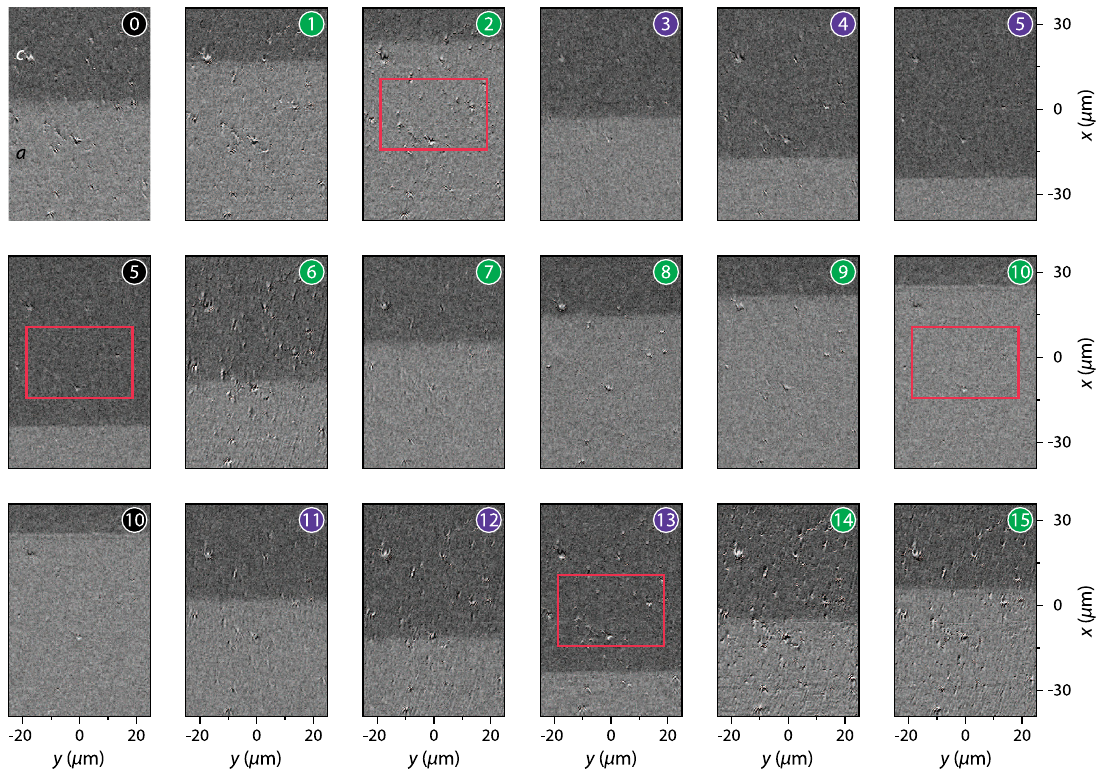
FIG. 3. Kerr-microscopy images illustrating the motion of a magnetic domain wall in an Fe film during the application of positive (green circles) and negative (violet circles) voltage pulses across the BaTiO 3 substrate. Black circles indicate that no voltage pulse is applied between two consecutive images. The pulse strength is j V j ¼ 100 V, which corresponds to an electric field of j E j ¼ 2 kV = cm. The red boxes denote an area for which magnetic hysteresis curves are measured after electric-field-driven magnetic domain-wall motion [see Fig.